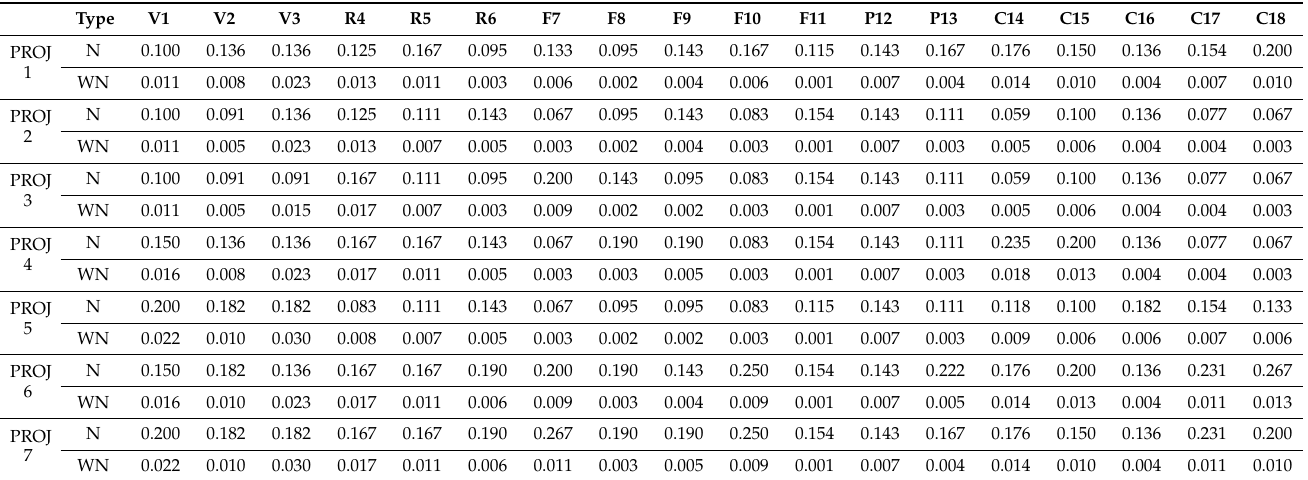
Figure 3. Real values for the list of factors in the Egyptian projects. Table 8. Normalized and weighted normalized decision